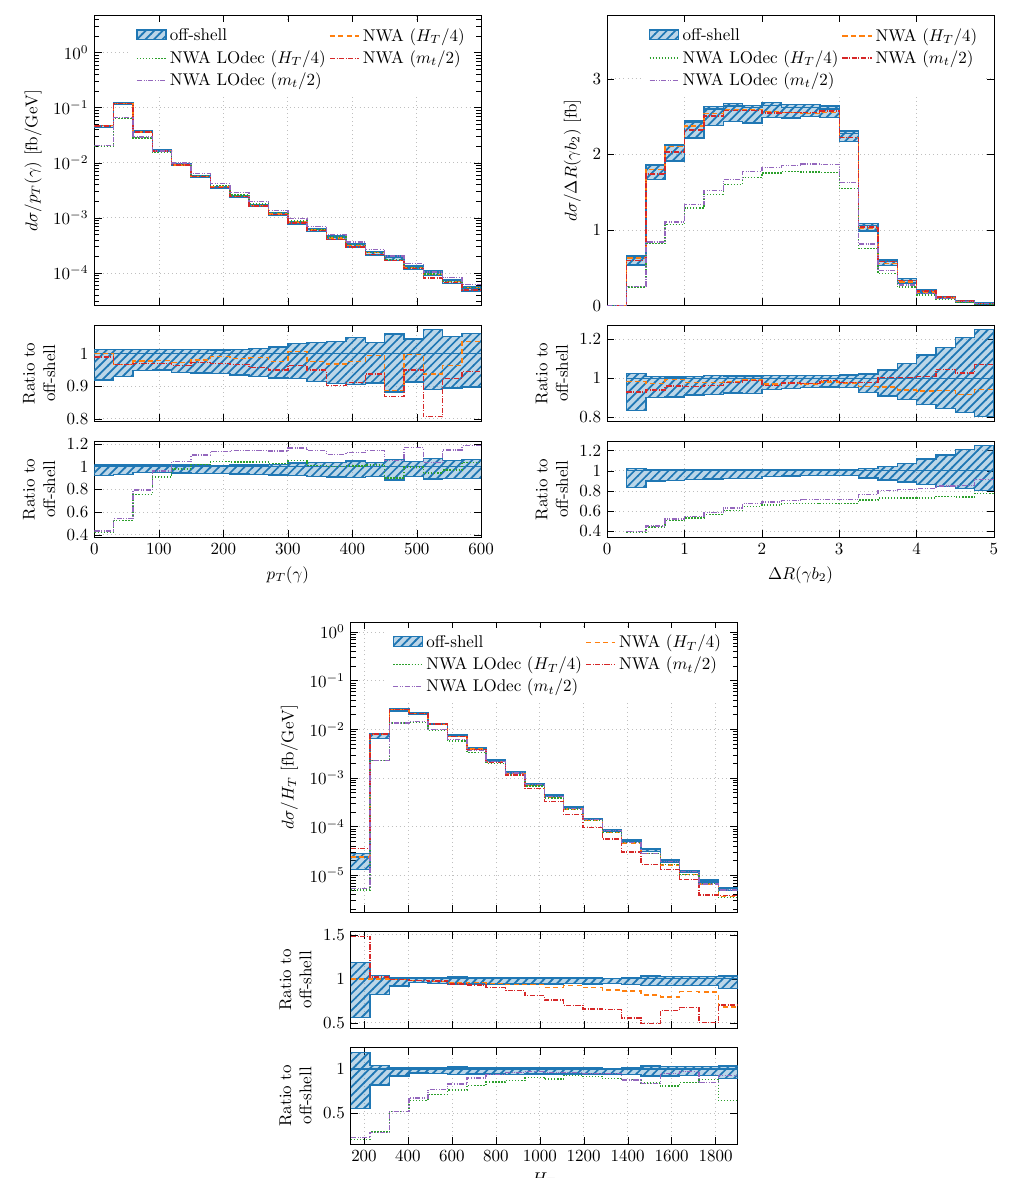
Figure 6 . Di(cid:11)erential cross section distribution as a function of the transverse momentum of the photon, p T ( (cid:13) ), the separation of the photon and the softest b -jet in the rapidity-azimuthal angle plane, (cid:1) R ( (cid:13)b 2 ), and the total transverse momentum of the e + (cid:23) e (cid:22) (cid:0) (cid:22) (cid:23) (cid:22) b (cid:22) b(cid:13) system, H T for the pp e + (cid:23) e (cid:22) (cid:0) (cid:22) (cid:23) (cid:22) b (cid:22) b(cid:13) process at the LHC run II with p s = 13 TeV. The CT14 PDF set is employed. !